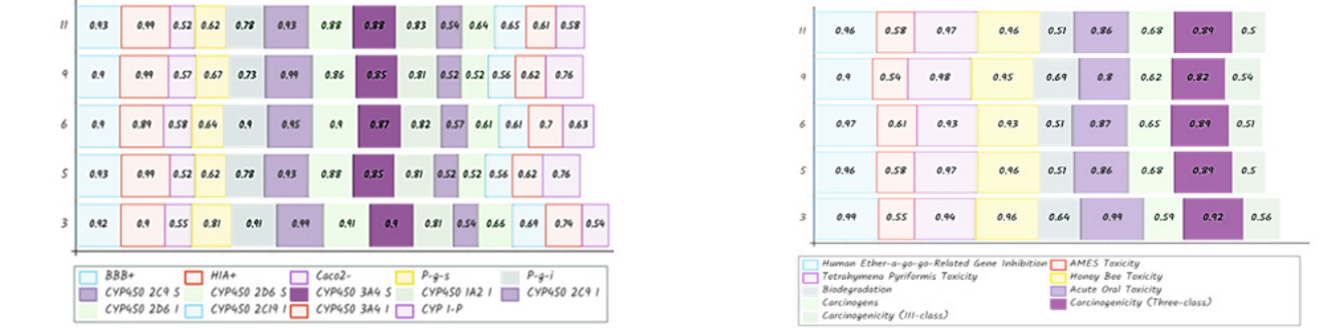
Figure 8. Absorption, distribution, and toxicity of pharmacokinetic parameters derived from the ADME-Tox for ligands ( 3,5,6,9 and11